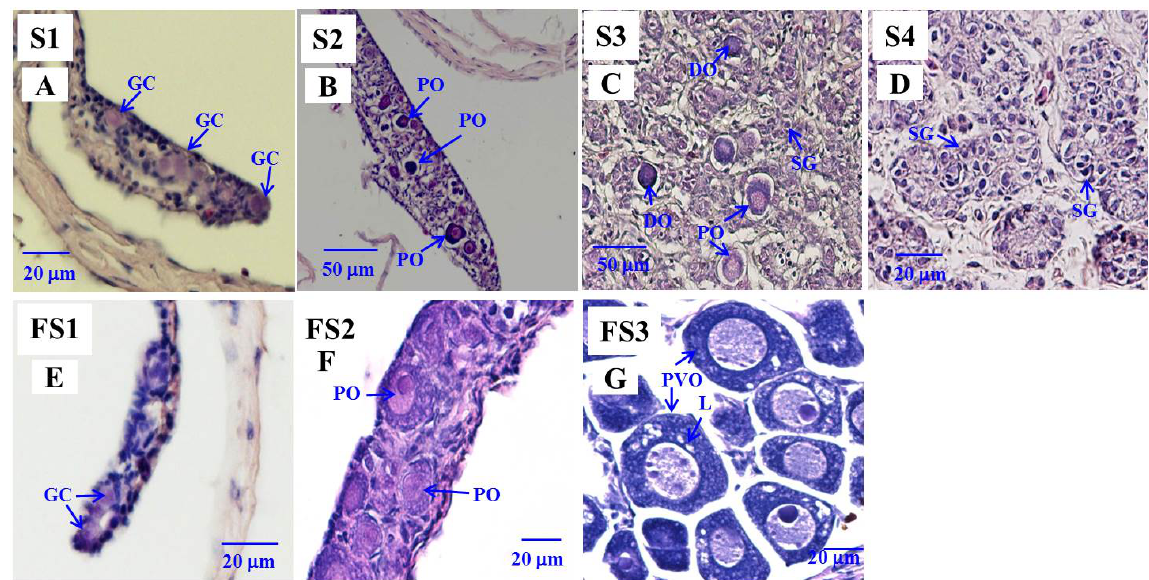
Figure 1. Gonad transverse sections, stained with hematoxylin and eosin of Japanese male eels at various stages (S1–S4) of testicular ( A – D ) differentiation and of estradiol-17 β (E2)-feminized Japanese eels at various stages (FS1–FS3) of sexual differentiation ( E – G ). ( A ) S1 stage, undifferentiated gonad. ( B ) S2 stage, early differentiating gonad. ( C ) S3 stage, late differentiating gonad. ( D ) S4 stage, differentiated testis. ( E ) FS1 stage, undifferentiated gonad. ( F ) FS2 stage, differentiating ovary. ( G ) FS3 stage, differentiated ovary. GC, germ cell; PO, primary oocyte; DO, degenerating oocyte; SG, spermatogonia cell; PVO, pre-vitellogenic oocyte; L, lipid droplet.